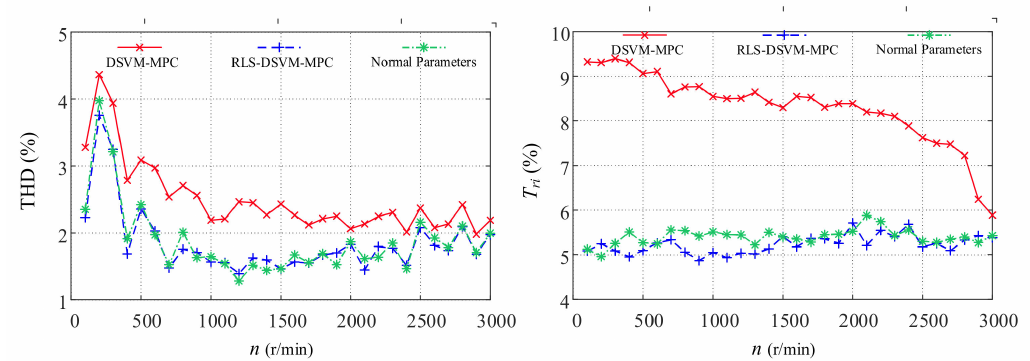
Figure 18. Performance of DSVM-MPC and RLS-DSVM-MPC at different